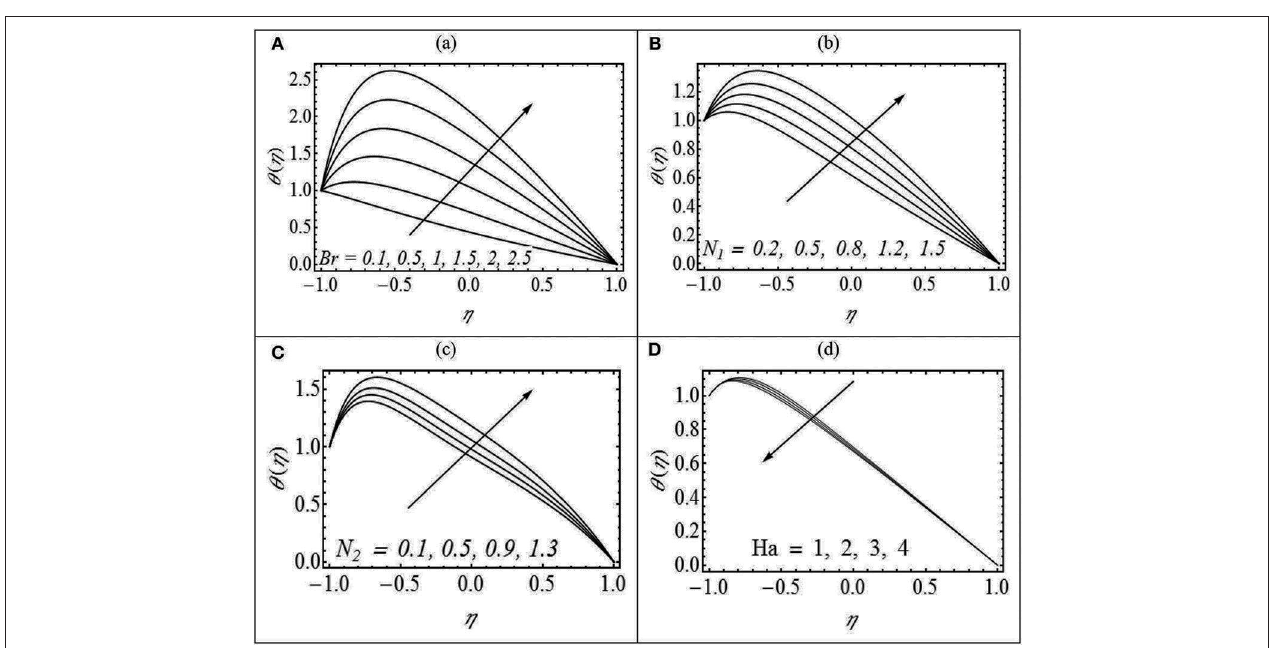
FIGURE 6 | (A–D) Variation in θ for various values of (A) Br with N 1 = 0.5, N 2 = 1.2, λ = 0.4, and γ = 2; (B) N 1 with Br = 2, N 2 = 1.2, λ = 0.4, and γ = 2; (C) N 2 with Br = 2, N 1 = 0.5, λ = 0.4, and γ = 2; and (D) Ha with N 1 = 0.5, N 2 = 1.2, λ = 0.4, and γ = 2.